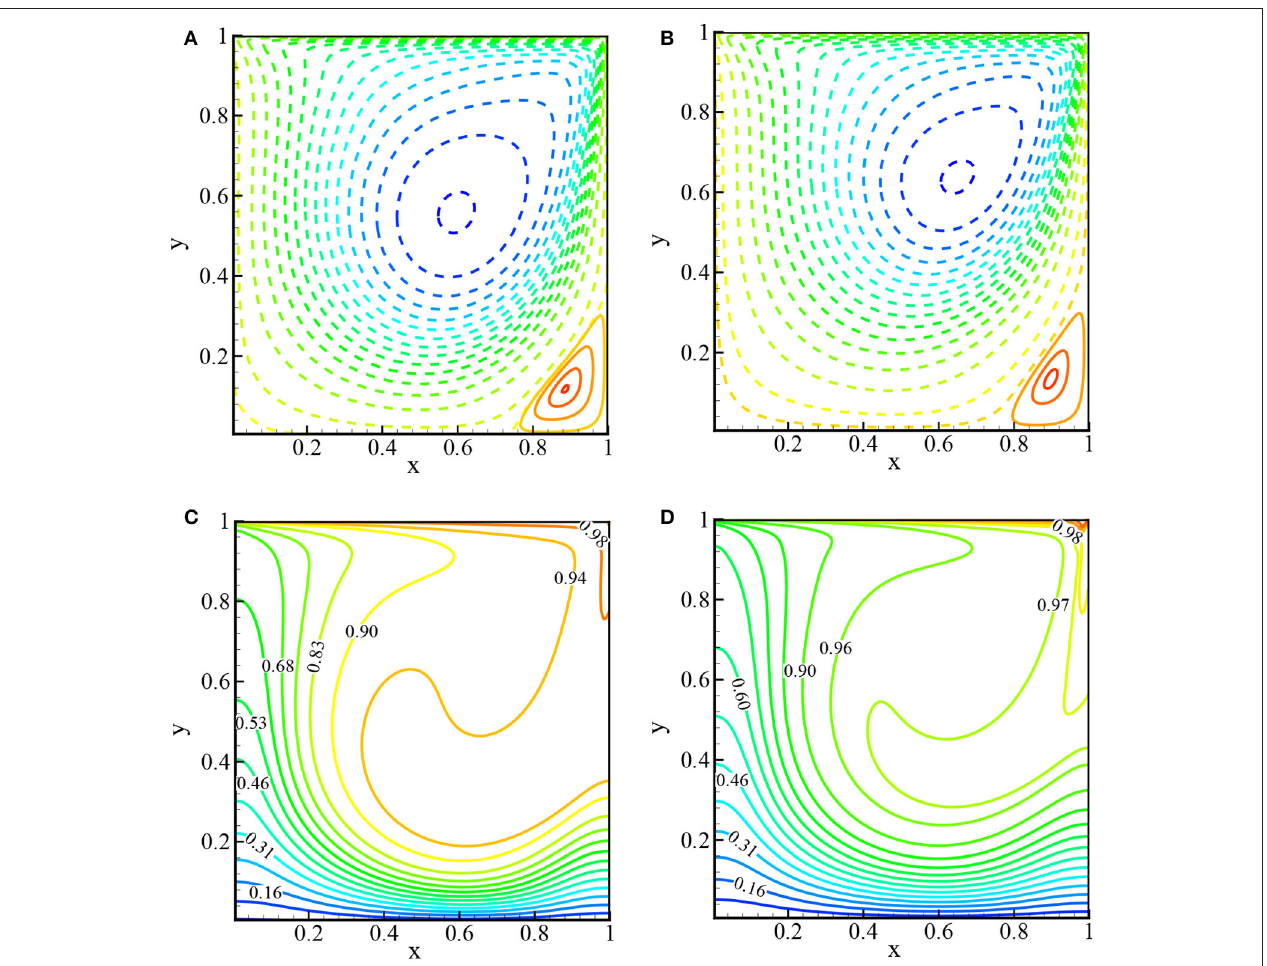
FIGURE 15 | Streamlines (top): (A) ǫ Da 10 − 2 . =